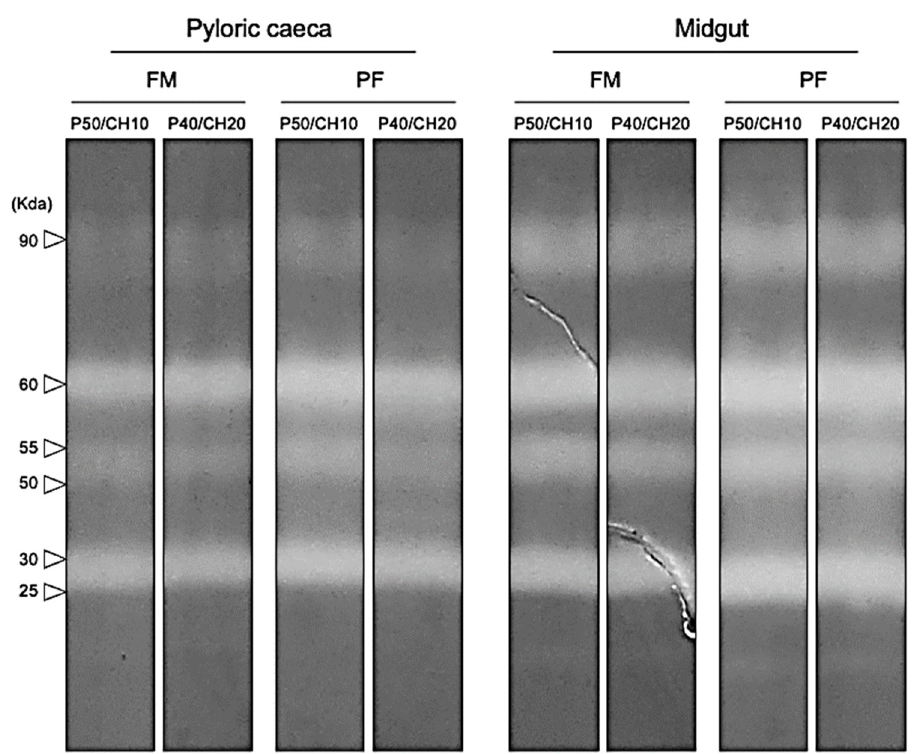
Figure 5. Representative model zymogram of alkaline proteases in pyloric caeca and midgut extracts. The molecular weight of each band with proteolytic activity is indicated. All samples were analyzed individually.